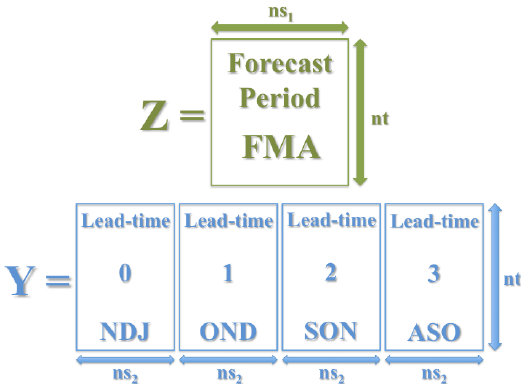
Figure 2. Predictand ( Z ) and predictor ( Y ) fields represented by their corresponding data matrices. The illustration relates to an example in which the forecast period covers the months February–March–April (FMA) and the predictor is selected for four distinct seasons: August–September–October (ASO, lead time = 3); September–October–November (SON, lead time = 2); October–November–December (OND, lead time = 1); November– December–January (NDJ, lead time = 0). Each of these sub- matrices for the predictor has the same temporal dimension ( n t ) and spatial dimension ( n s 2 ). The predictand may have a different spa- tial dimension ( n s 1 ) but the same temporal dimension ( n t ) to enable matrix calculations required by MCA